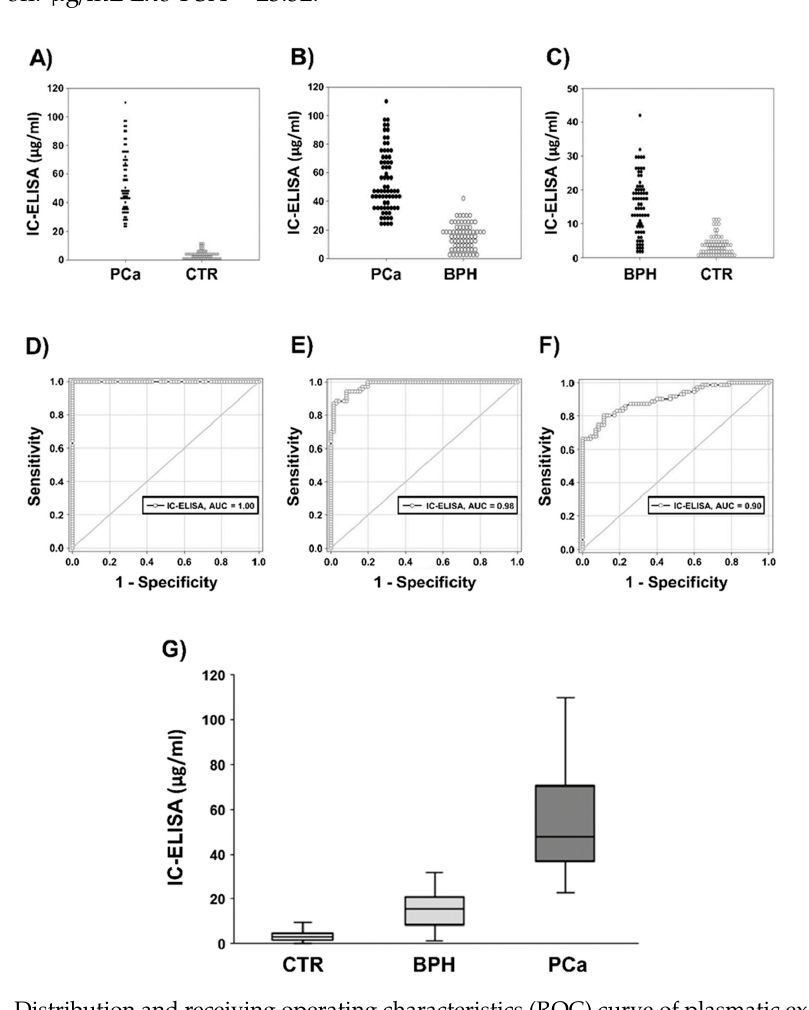
Figure 1. Distribution and receiving operating characteristics (ROC) curve of plasmatic exosomes expressing PSA (Exo-PSA) from healthy donors (CTR), benign prostatic hyperplasia (BPH), and prostate cancer (PCa) plasma samples analyzed with immunocapture-based ELISA (IC-ELISA). ( A ) Distribution between PCa and CTR. ( B ) Distribution between PCa and BPH. ( C ) Distribution between BPH and CTR. ( D ) ROC curve between PCa and BPH. ( E ) ROC curve between PCa and BPH. ( F ) ROC curve between BPH and CTR. ( G ) IC-ELISA distribution of CTR, BPH, and PCa included within the 25th and 75th percentiles.